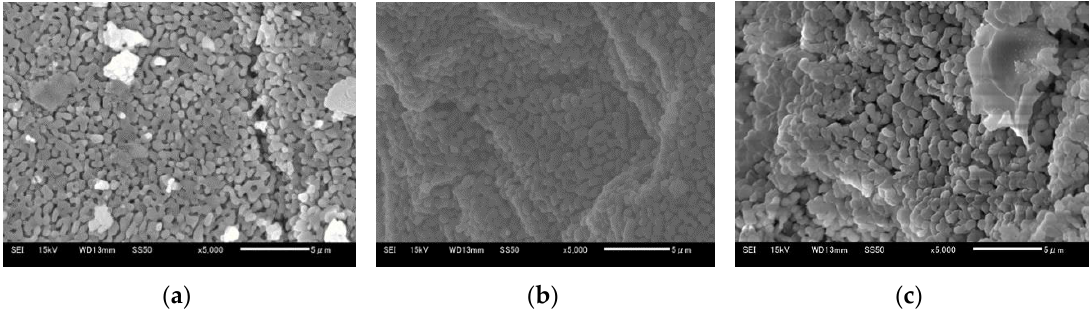
Figure 13. SEM images of 710–1000 µmφ ( a ) Ofunato CaO, ( b ) Ofunato Ca(OH) 2 after 1st hydration reaction, ( c ) Ofunato CaO after 1st dehydration reaction after decarbonization at 1223 K for 5 h. in muffle furnace.